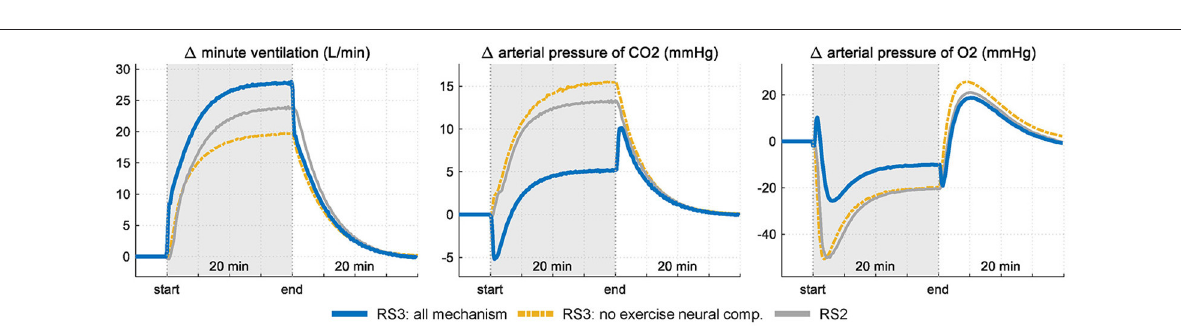
FIGURE 6 | Response of RS3 to a step exercise input under two conditions: firstly, with all mechanism of respiratory control operative and, secondly, without the neurogenic mechanism MRV (see Equation 3). Results are compared with those obtained in RS2 for the same stimulus. Variations of each variable are showing regarding their respective rest